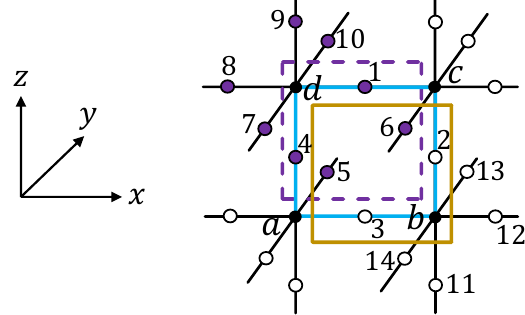
Figure 38: The framing of the hopping term defined previously is indicated by the brown square, while the gauge constraint involves the X operators in the opposite framing (purple dashed